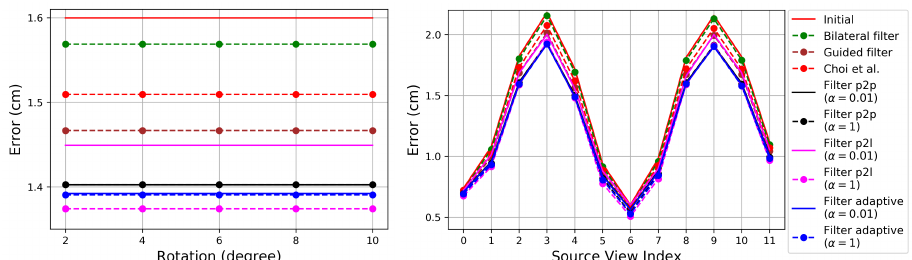
Figure 4. Evaluation of the depth refinement algorithms on the synthetic dataset of Choi et al. [26]. The algorithms are initialized with the ground-truth pose parameters, so there is no pose estimation error. ( Left ): Error according to different perturbation levels in the rotational component. The errors are constant without pose estimation error. The main cause of the registration errors are depth errors. ( Right ): Error according to the source view index.